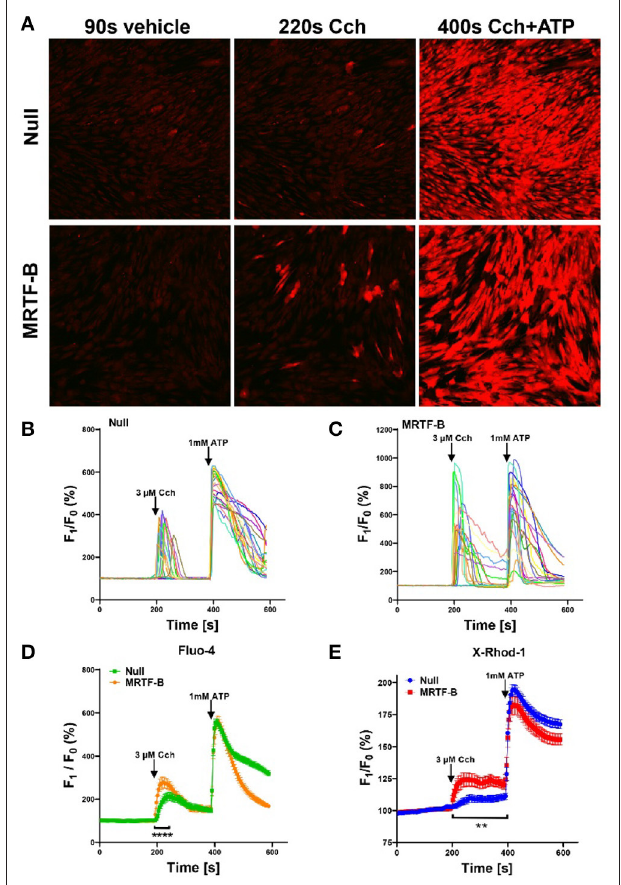
FIGURE 6 | Ca2 + imaging of MRTF-B-transduced human coronary artery SMCs. To examine if MRTF-B transduction increases responsiveness to the muscarinic agonist carbachol, cells were treated as indicated for 5 days in culture. They were subsequently washed and loaded with Fluo-4 and imaged using confocal microscopy. Only a fraction of the cells responded to carbachol [ (A) , middle], but the responses were larger in MRTF-B-transduced cells. (B , C) Show the 20 cells responding best to carbachol in the experiment in (A) . (D) Shows compiled data from three independent experiments with Fluo-4. The Ca2 + signal between 200 and 250s was significantly increased by prior MRTF-B transduction. (E) Shows intracellular Ca2 + in human coronary artery SMCs after transduction of MRTF-B or null virus, respectively ( N = 6), but measured Ca2 + using X-Rhod-1. Error bars in (D,E) represent 95% confidence intervals. **** p < 0.0001 and ** p < 0.01.